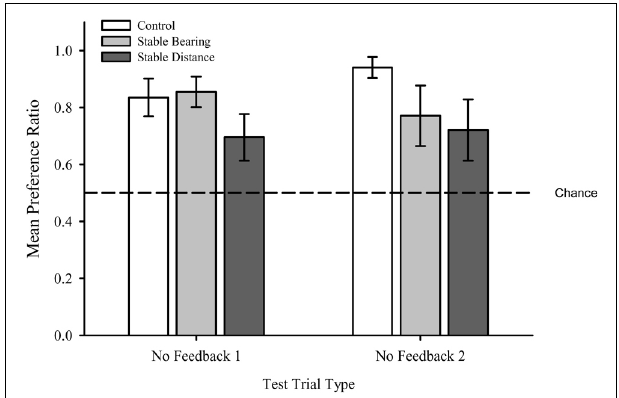
FIGURE 4 | Mean preference ratio during No Feedback trials for each group. Dashed line represents chance performance (0.5). Error bars represent standard errors of the means.